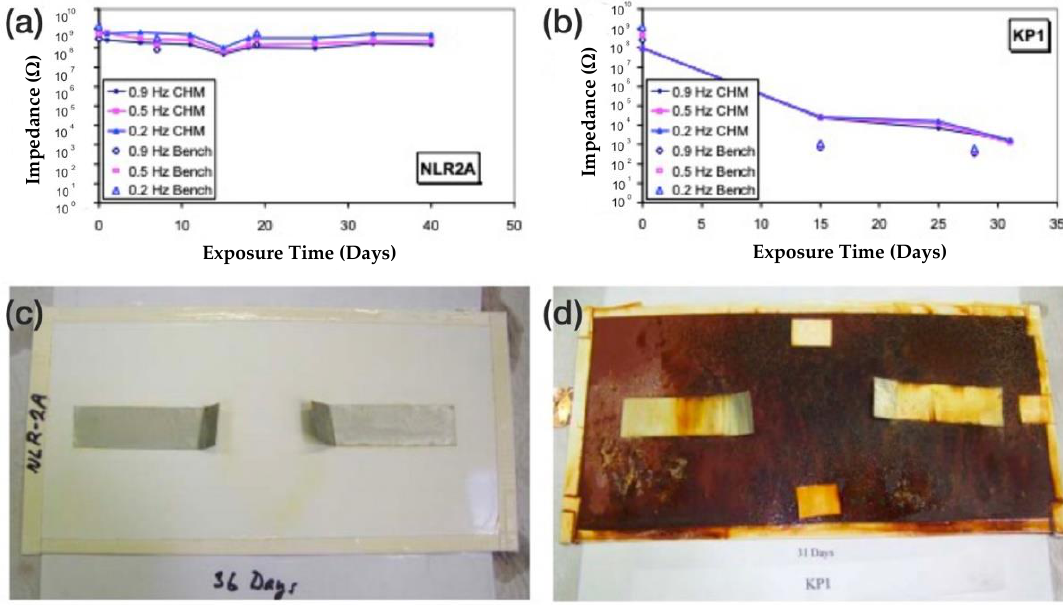
Figure 6. ( a ) An example of an effective coating showing high stable electrochemical impedance and a metallic substrate in good condition Vs. ( b ) an ineffective coating with low impedance and generalised corrosion on the substrate, ( c ) State of degradation of the NLR2A system corrosion after 36 days, ( d ) State of degradation of the KP1 system corrosion after 31 days [78].